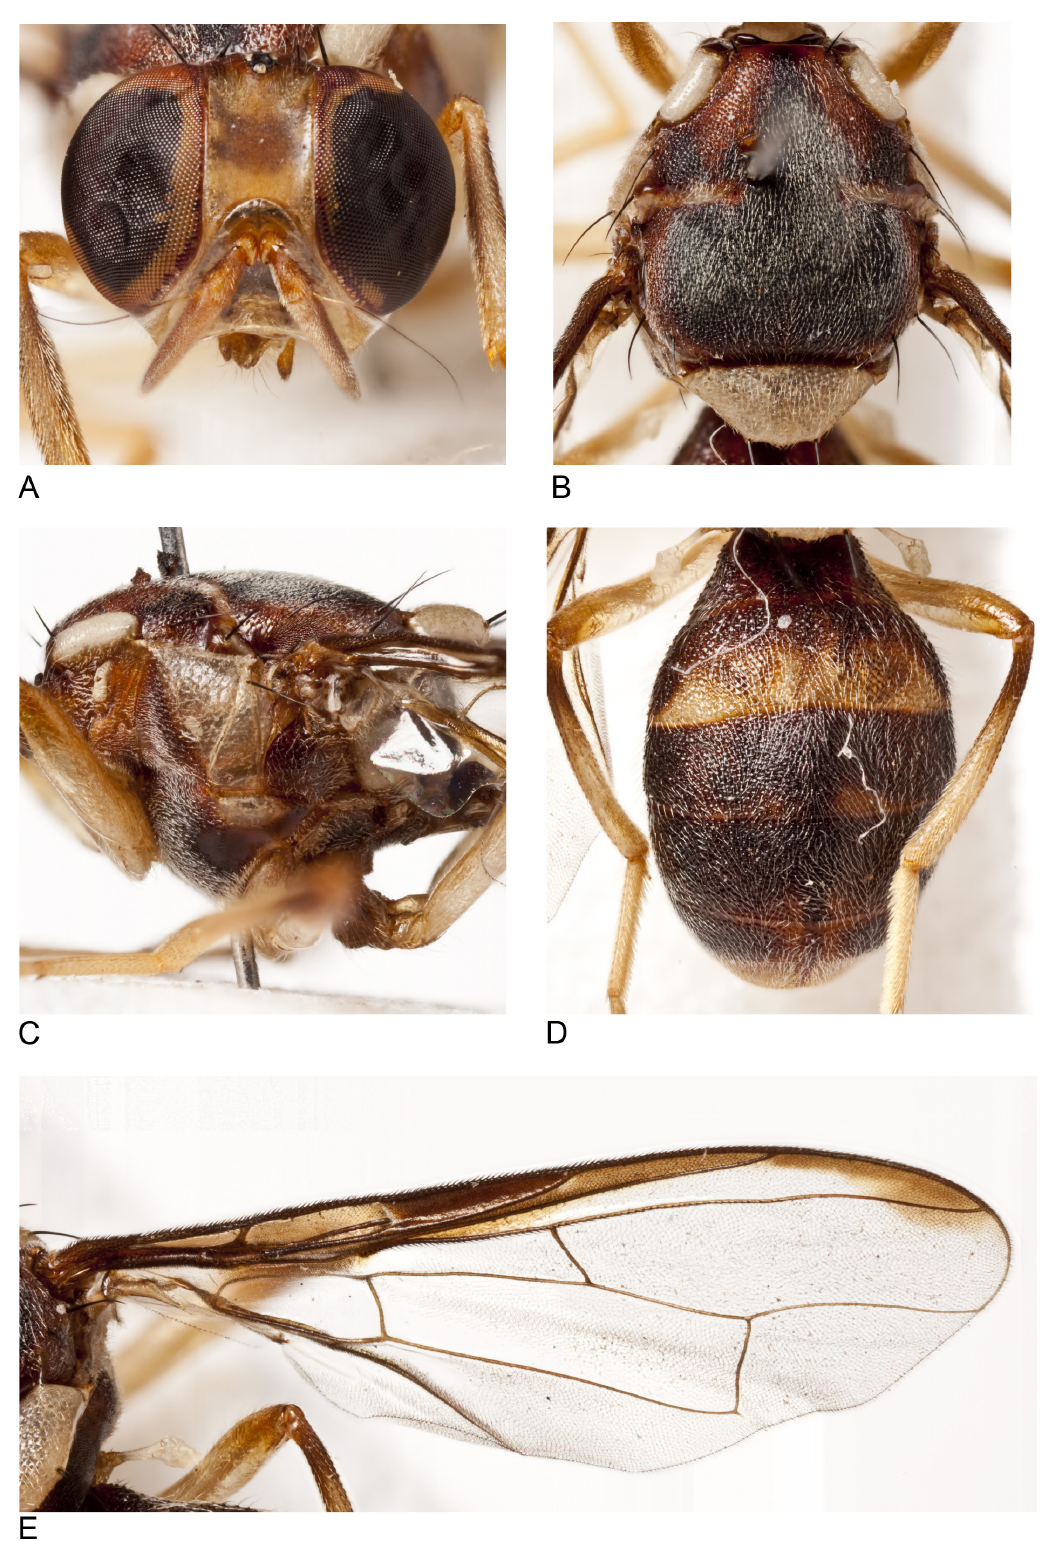
Fig. 4. Dacus goergeni sp. nov. A . head, frontal view. B . thorax, dorsal view. C . thorax, lateral view. D . Abdomen, dorsal view. E .